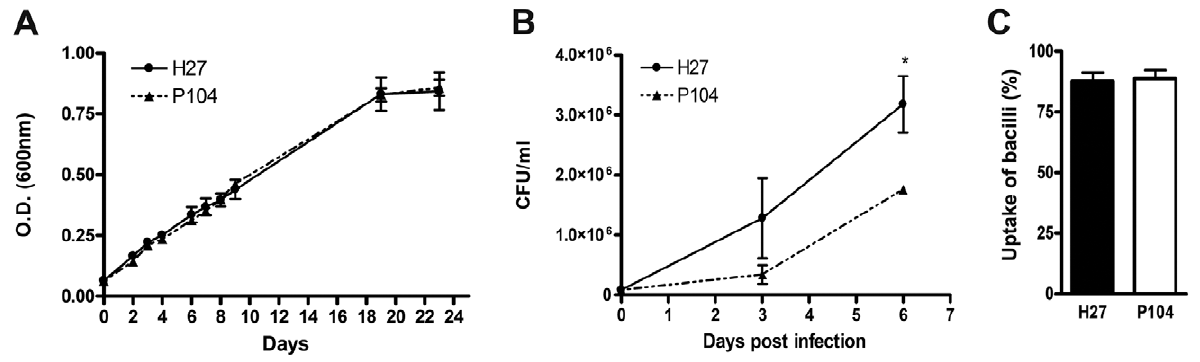
Figure 1. Capacity of H27 and P104 M.avium strains to grow in macrophages and 7H9 broth. Bacterial growth in the broth within 24 days was evaluated by spectrophotometry (A). Bone marrow cells were obtained from C57BL/6 mice and differentiated to macrophages in vitro . The resulted cells were infected at a MOI 1:1 bacteria/macrophage, incubated for 3 h at 37 u C, washed, tested for the mycobacterial uptake, and cultivated for additional 6 days. The resulted cells were lysed and CFU numbers (B) were quantified as indicated in Material and methods. The percentage of macrophages with internalized mycobacteria in the culture was quantified 3 h after infection by Ziehl-Neelsen method (C). The data obtained in three independent experiments are presented as mean 6 SD of samples in triplicate. Asterisk represent statistical significance (*p , 0.05).